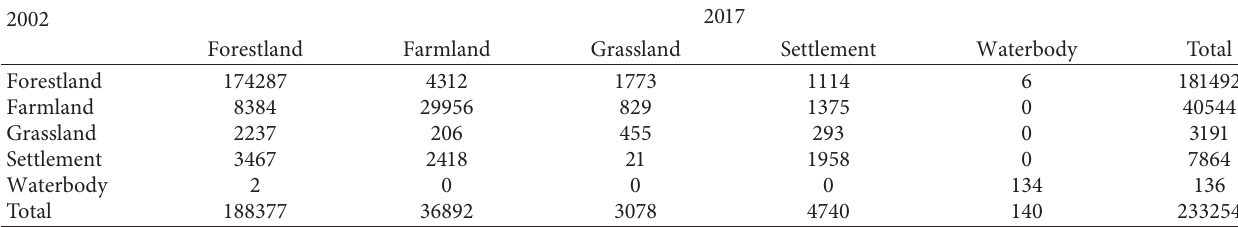
Table 8: Transition area matrix (ha) between 2002 and 2017 in MFBR.